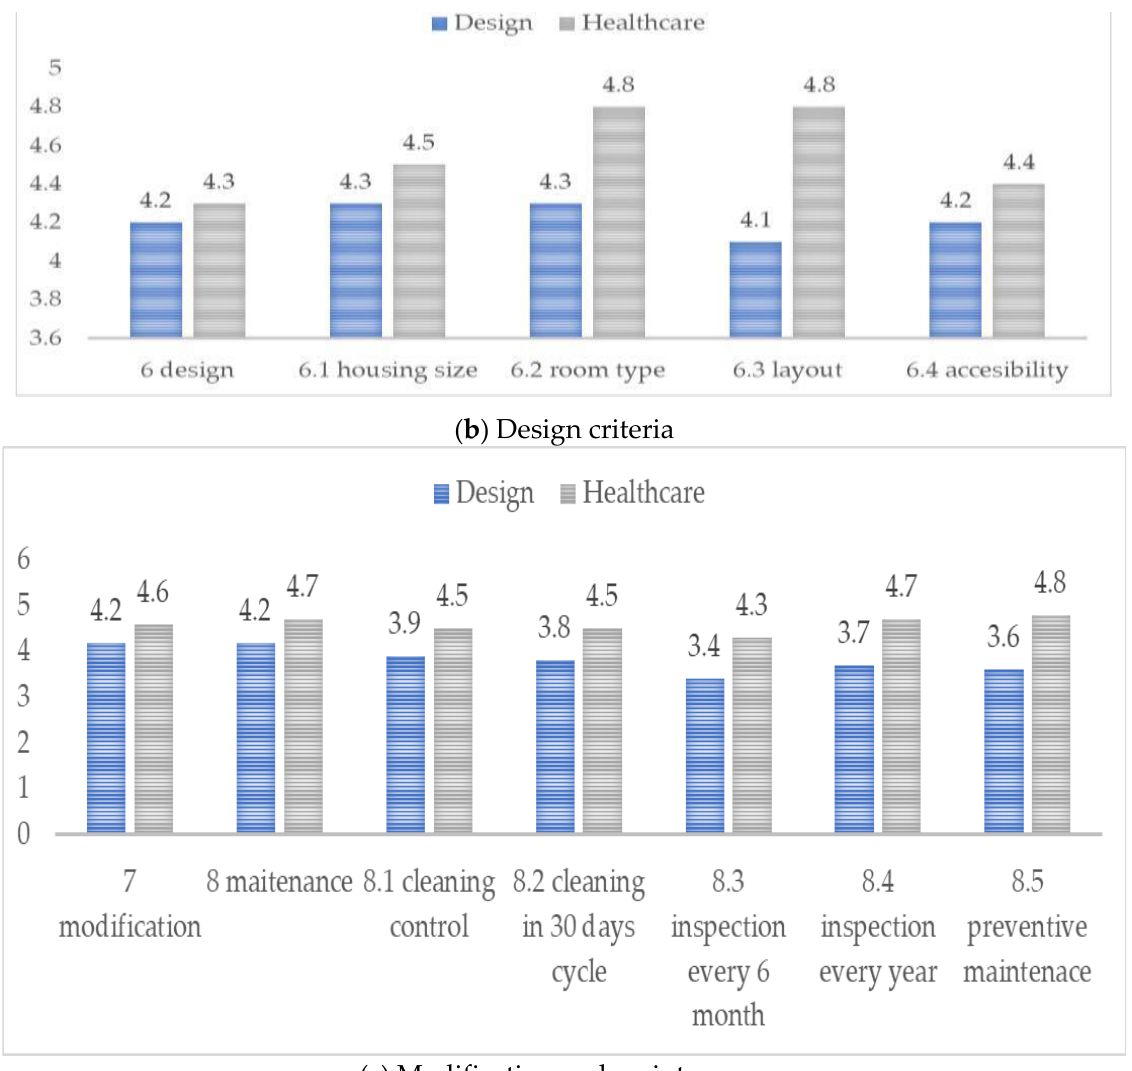
Figure 7. Criteria 5 – 8 result; ( a ) essential services; ( b ) design criteria, and ( c ) modification and maintenance.